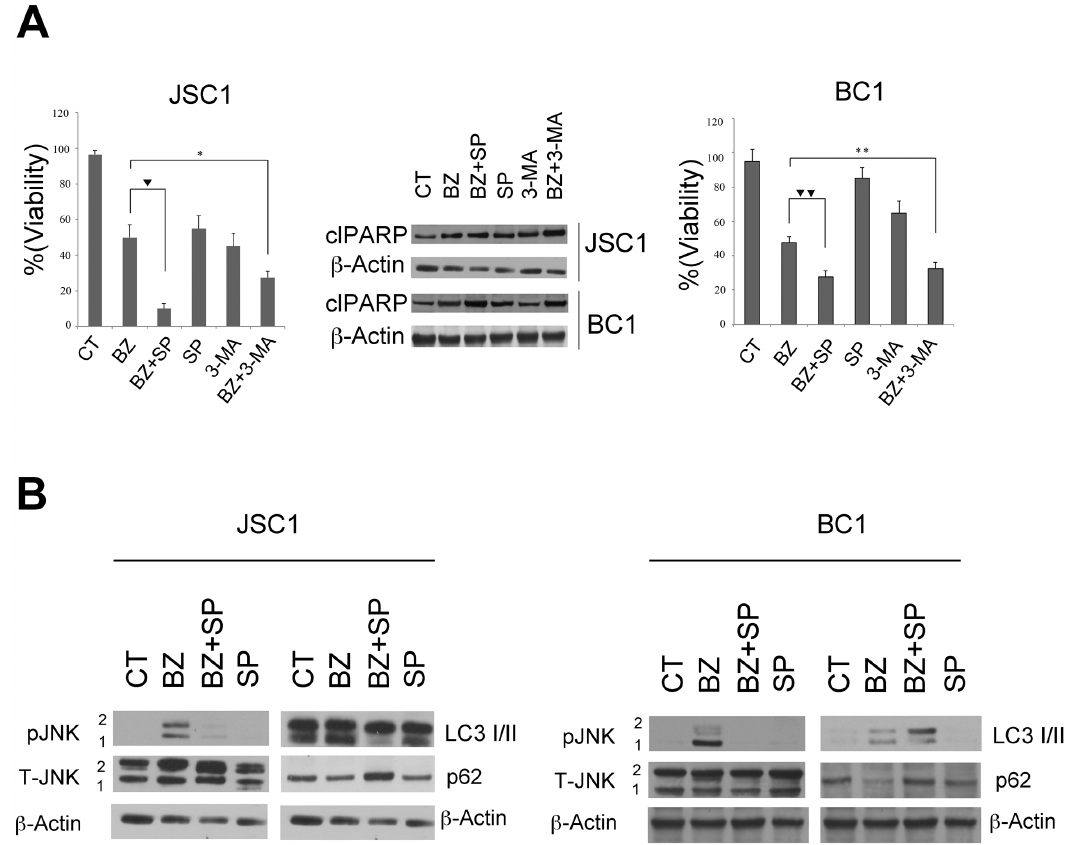
Figure 5. Inhibition of autophagy with 3-MA or with JNK inhibitor increases the Bortezomib anti-proliferative effect in JSC1 and BC1 PEL cells. (A) Viability assay evaluated by trypan blue exclusion was performed in JSC1 (left panel) and BC1 (right panel) cells treated with bortezomib (20 nM) or 3-MA (5 mM) or SP600125 (20 m M) alone or in combination for 16 hrs. Mean 6 the standard deviation was also indicated (n=3 experiments). * p-value = 0.05, ** p-value = 0.05, ¤ p-value = 0.01, ¤¤ p-value = 0.02. Western blotting analysis was performed on JSC1 and BC1 cells to evaluate the expression of cleaved (cl) PARP p85 fragment. b -actin was used as loading control (middle panel). JSC1 and BC1 cells were treated with bortezomib (20 nM for 16 hrs) with or without pre-treatment with JNK inhibitor (SP600125) (20 m M). Total cell lysates